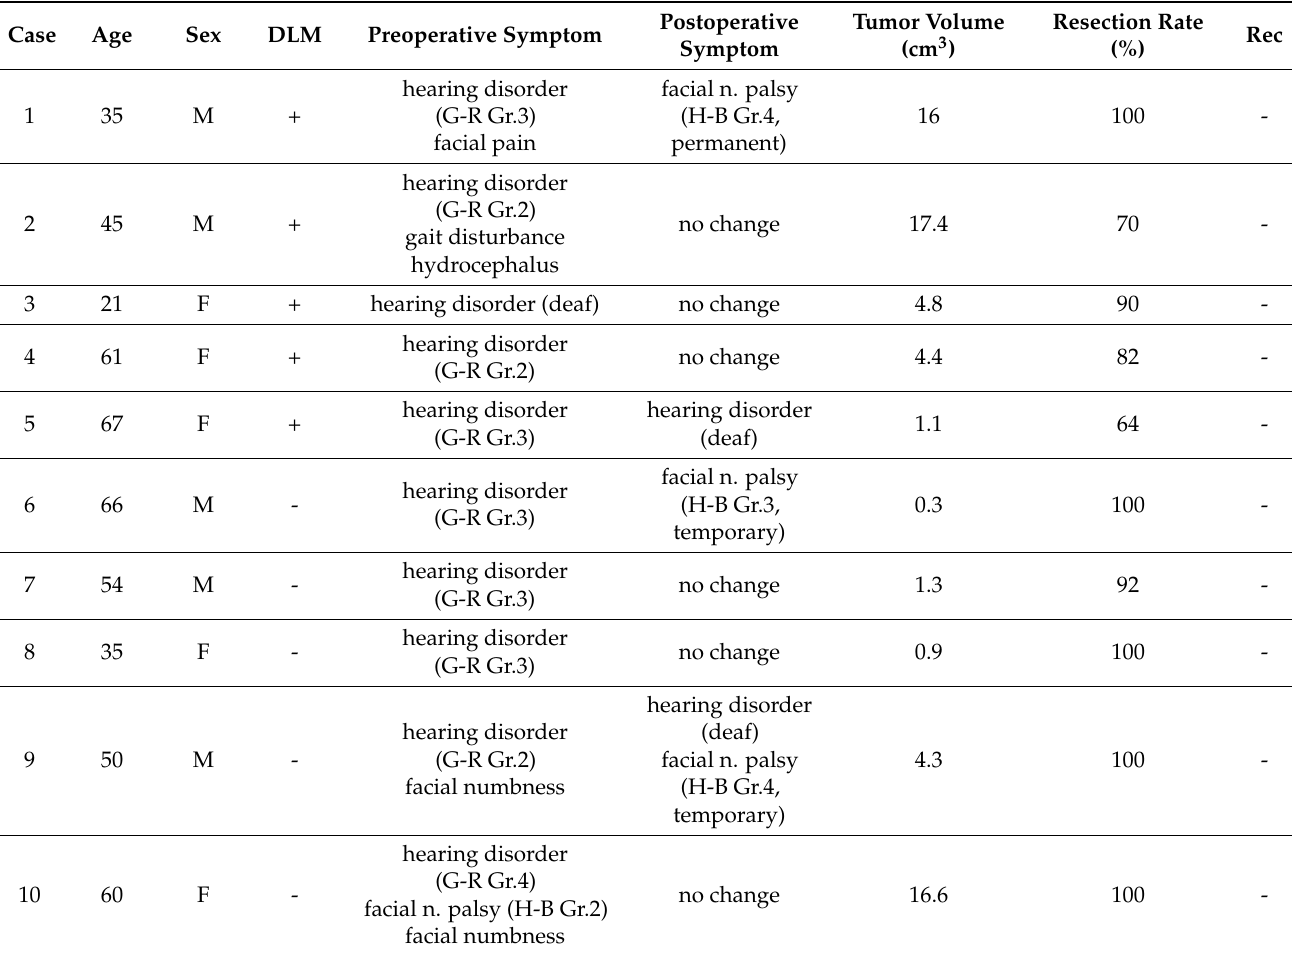
Table 1. Patients’